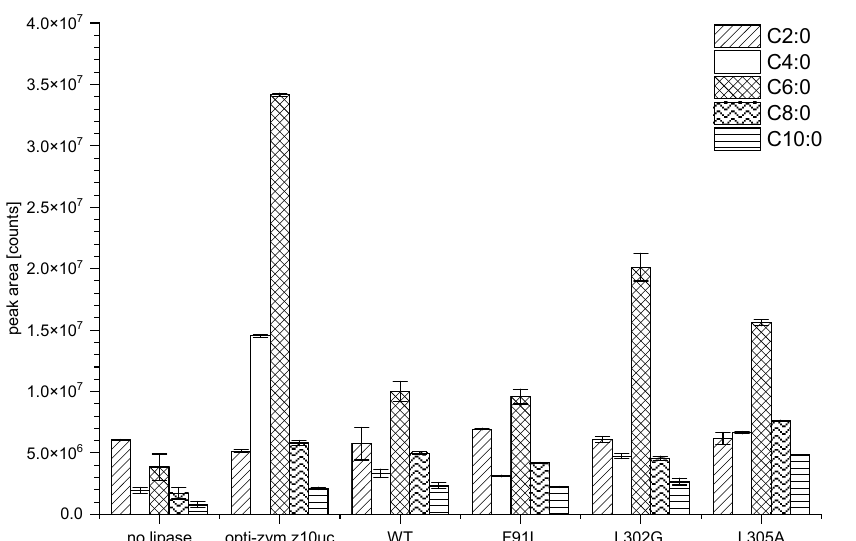
Figure 2. Feta-type brine cheese produced without addition of lipase, the reference PGE opti-zym z10uc, PCI_Lip WT (1 U), F91L (1 U), L302G (0.7 U), and L305A (1 U) after 30 d of ripening at 13 °C. Shown are peak areas of selected vFFA from the cheese samples after SPME-GC-MS analysis. The measurements were performed in duplicates and the error bar corresponds to the mean deviation. C2:0 = acetic acid, C4:0 = butyric acid, C6:0 = hexanoic acid, C8:0 = octanoic acid, and C10:0 = decanoic